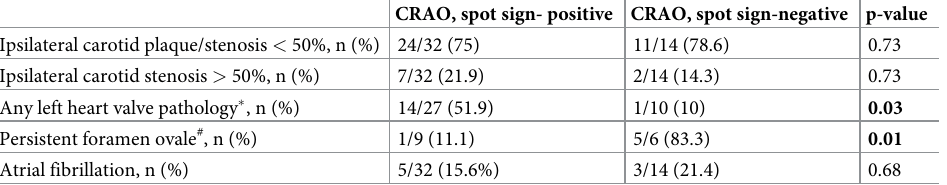
Table 2. Comparison of sonographic findings in patients with and without the presence of the spot sign in the subgroup of patients with CRAO. CRAO, spot sign- positive CRAO, spot sign-negative p-value Ipsilateral carotid plaque/stenosis < 50%, n (%) 24/32 (75) Any left heart valve pathology � , n (%) Persistent foramen ovale # , n (%) 1/9 (11.1) Atrial fibrillation, n